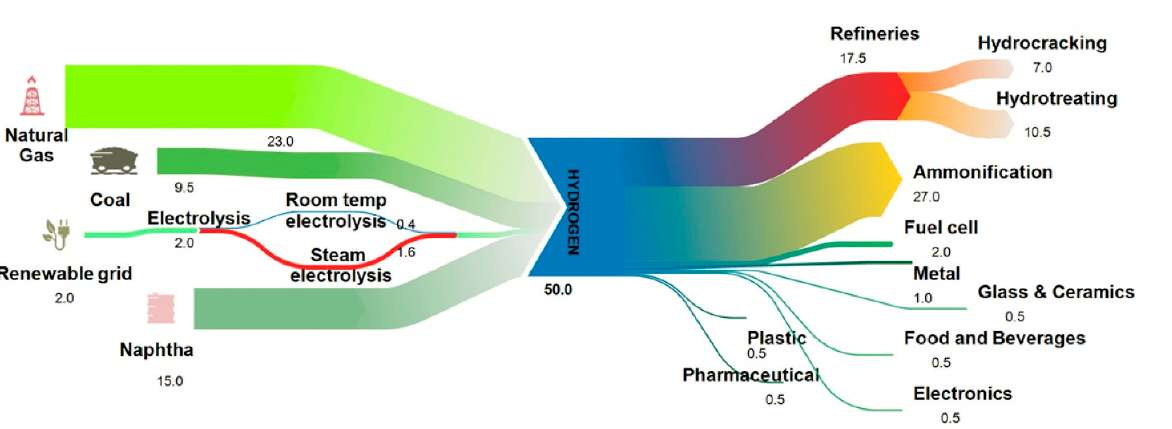
Figure 6. The average hydrogen supply and demand globally, measured in million metric tons